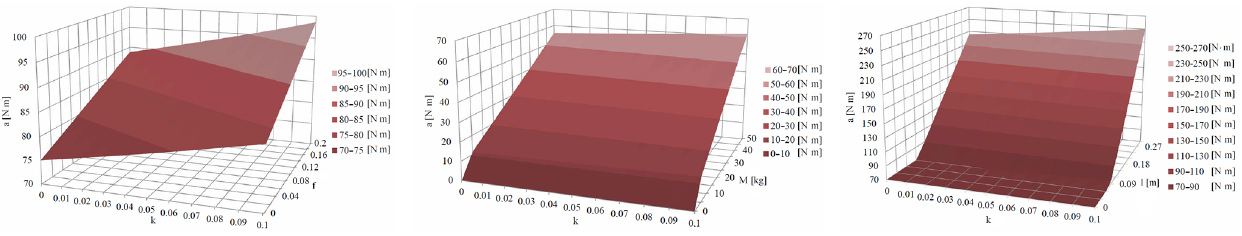
velocity remains